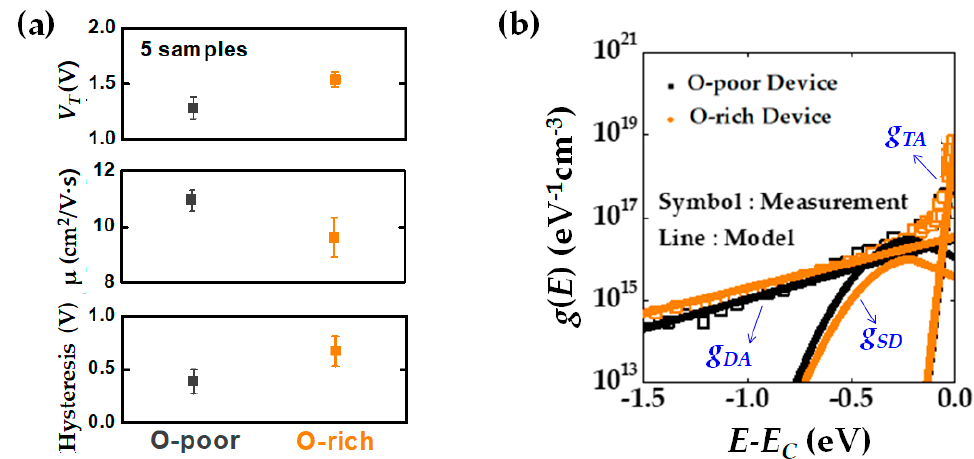
Figure 5. Characteristic comparisons between O-poor and O-rich a-IGZO devices: ( a ) Electrical characteristics (threshold voltage, mobility, and hysteresis) of O-poor and O-rich devices; ( b ) Experimentally extracted DOS distributions of two devices by using MPCV method. Black and orange symbols indicate O-poor and O-rich device, respectively.